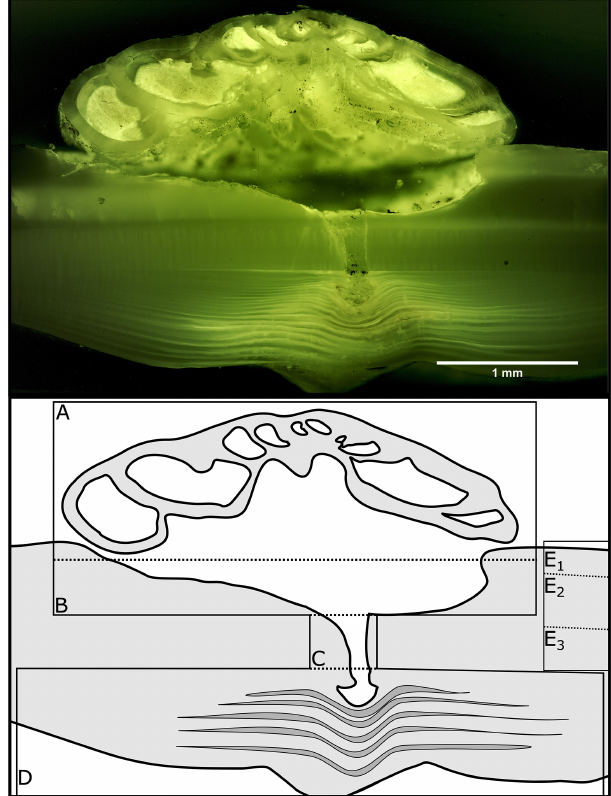
Figure 1. Fluorescence microscopic image (excitation 420–490nm) and schematic figure of H. sarcophaga on A. excavata . A: H. sar- cophaga ; B: attachment depression corroded by H. sarcophaga ; C: bored canal; D: callus built by A. excavata (SRZ: shell repair zone); E: undisturbed shell; E 1 : calcitic shell layer (fibrous); E 2 : calcitic shell layer (microgranular); E 3 : aragonitic shell